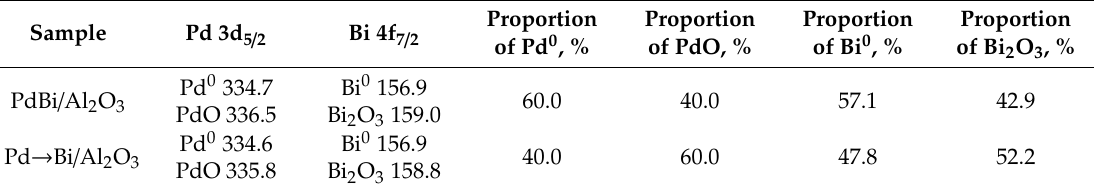
Table 6. Binding energy (eV), atomic percent Pd, Bi and a proportion of metallic and oxide phases of